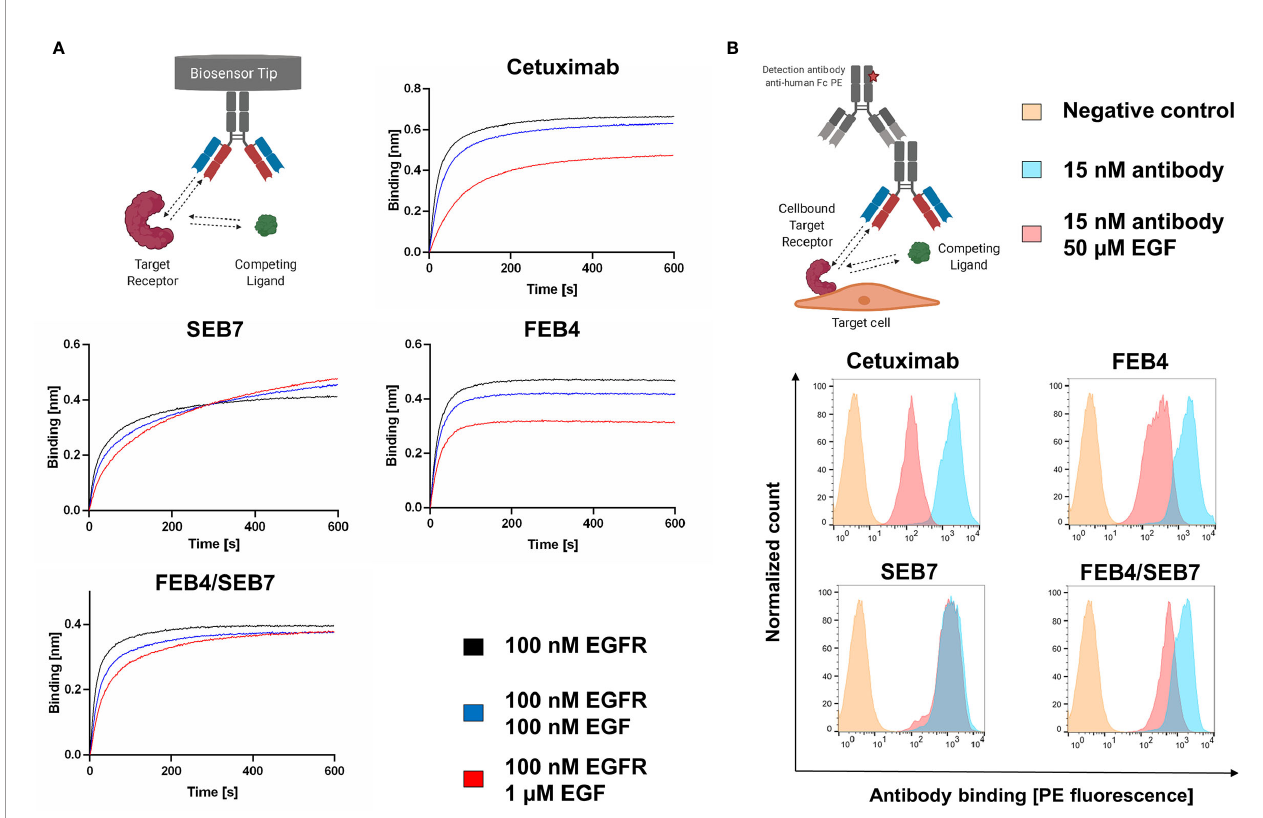
FIGURE 4 | EGF competition assays. (A) BLI-based EGF competition. Using AHC biosensors, the depicted antibodies were loaded followed by association to EGFR preincubated with varying EGF concentrations. (B) EGF-dependent binding to EGFR +++ A431 cells. 1×10 6 A431 cells were stained utilizing antibodies preincubated with or without EGF. Binding to A431 cells was measured by FACS using the goat anti-human Fc PE antibody. Created with